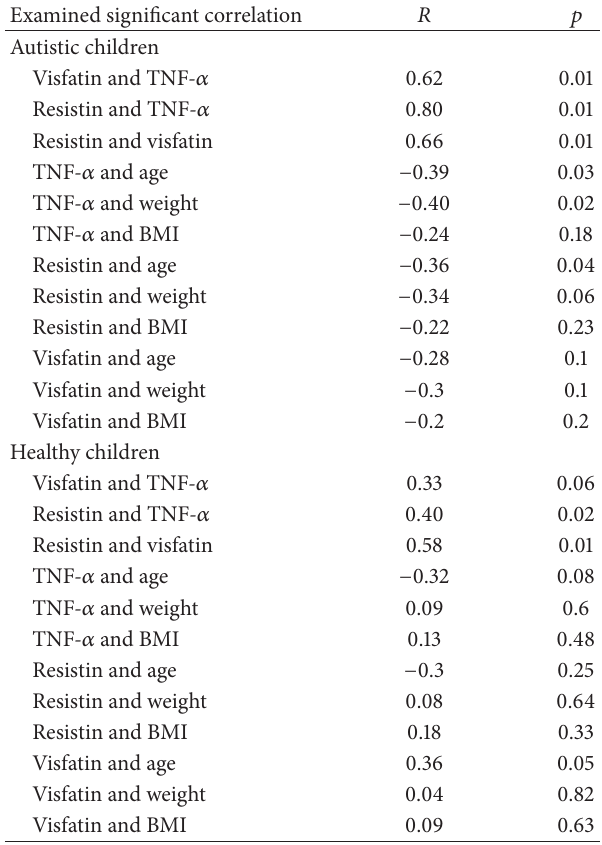
Table 4: Correlations of TNF- 𝛼 , resistin, and visfatin serum levels in autistic and healthy